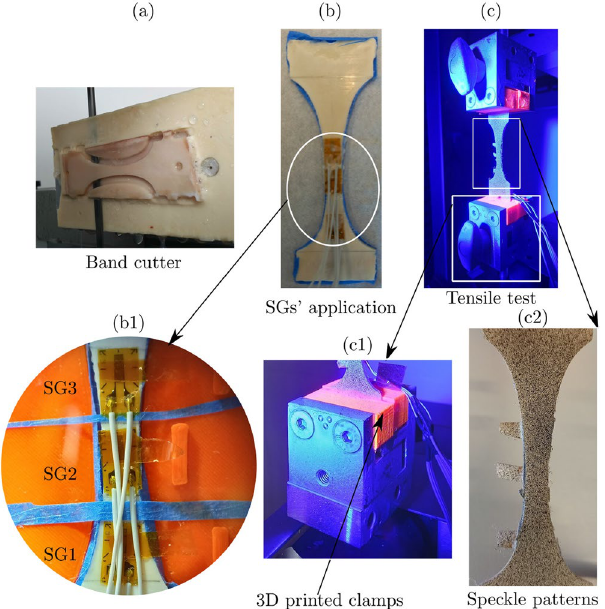
Figure 3. Preparation steps of the bovine bone specimens. ( a ) Bone specimens were sliced using an Exakt cutter, ( b ) SG1, SG2 and SG3 were applied on the specimen’s back, ( c ) mechanical test setup, ( c1 ) the bone specimen was fixed to external clamps, and ( c2 ) speckle patterns were applied on the specimen’s